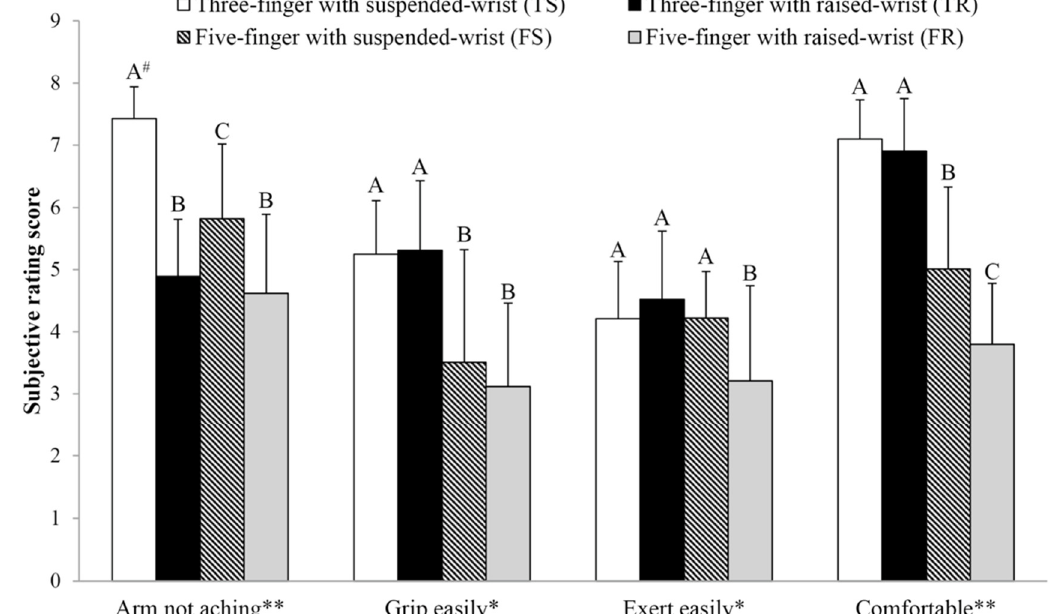
Figure 6. The differences between the four Chinese brush operations on selected subjective responses (all p < 0.05; # means post hoc group results).